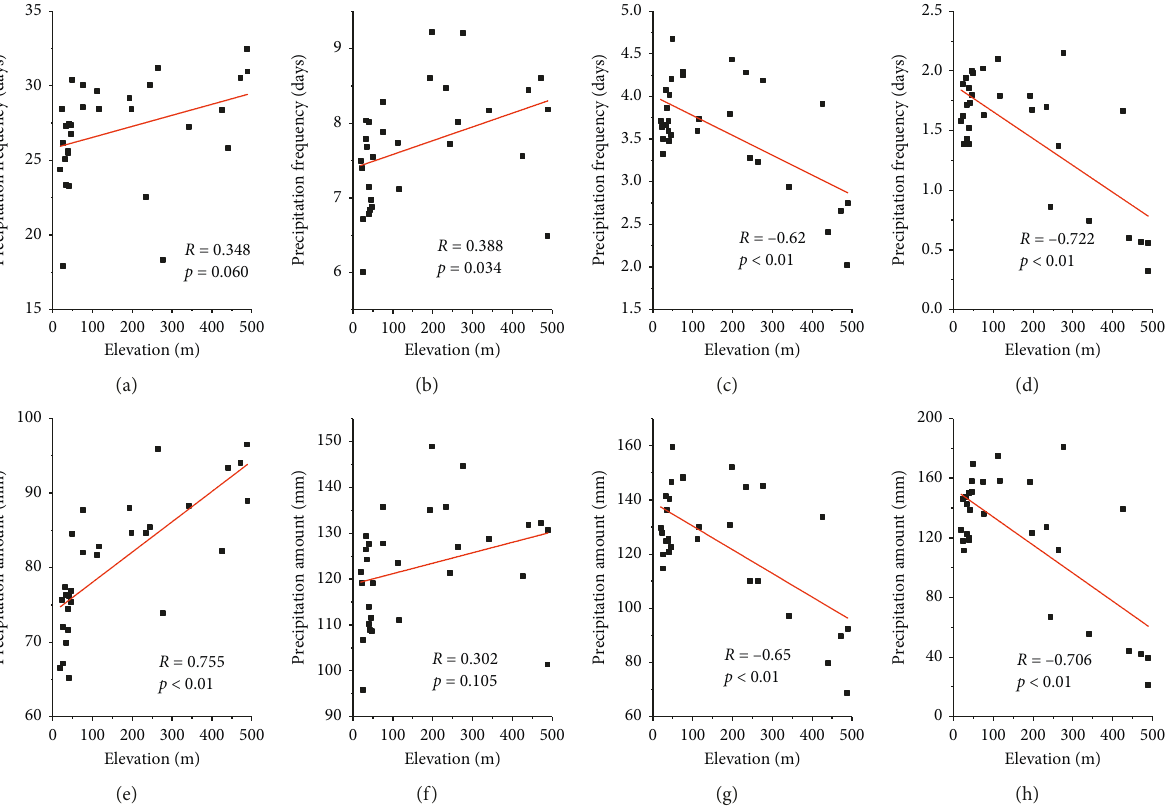
Figure 10: Spatial distribution of precipitation frequency and amount for the different grades during 1960–2012. (a, e) Small precipitation. (b, f) Medium precipitation. (c, g) Large precipitation. (d, h) Heavy